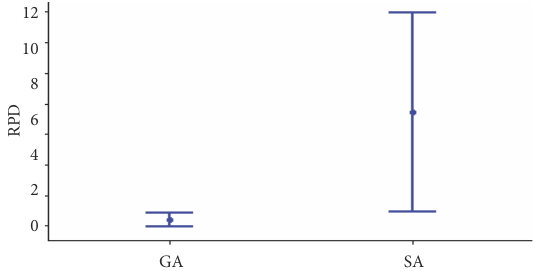
Figure 16. Comparison of computational times for the GA and the SA algorithms in small-sized